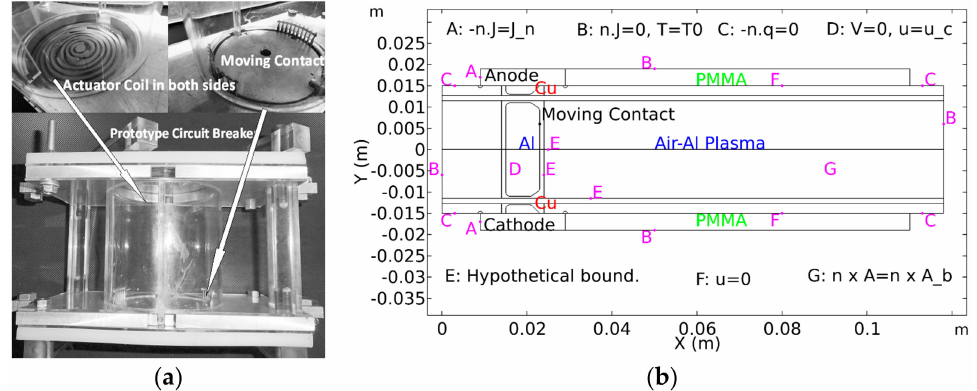
Figure 1. ( a )Elementsofprototypefastswitch(FS)andThomsoncoil,( b )2-Dgeometry,andinitialconditions. Moving contact (MC) is made from aluminum (Al), while the fixed contacts are made of copper (Cu). The initial gap between the electrodes is 2 mm. The wall of the chamber is made of transparent Poly-methyl-methacrylate (PMMA), known as plexiglass. The length of the arc chamber is 11 cm, and there are two pairs of open hatches at the bottom and the top of the chamber, as shown in Figure 1a. The moving contact is accelerated by the repulsive force generated by a Thomson